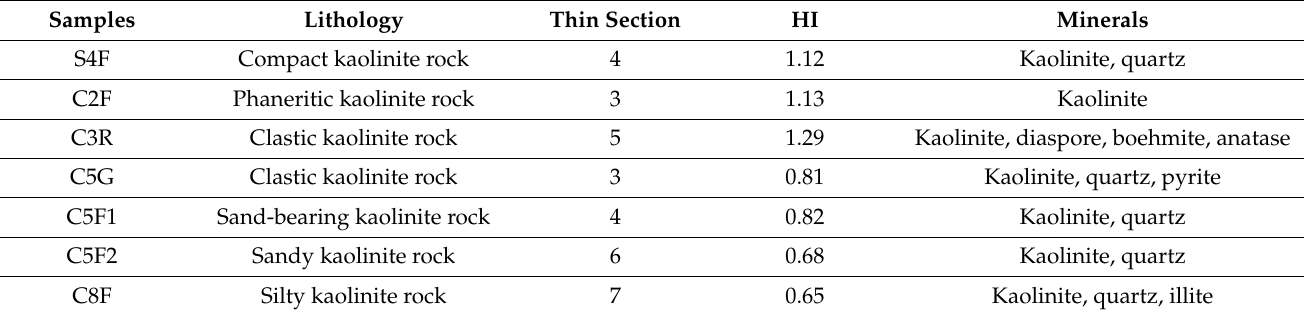
Table 1. The HI and mineral composition of coal-measure kaolinite rock in Xiaoyu mine.